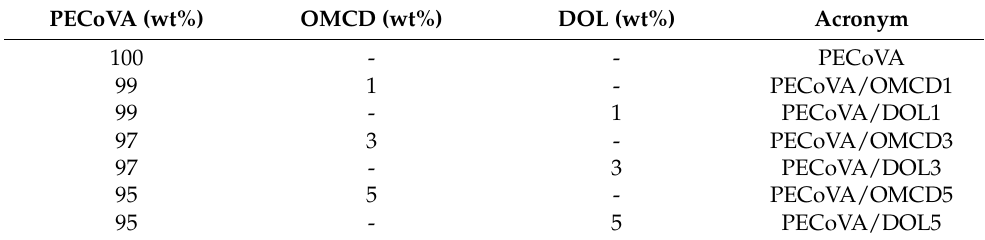
Table 1. Formulation and acronyms of PECoVA/dolomite composites. PECoVA (wt%) OMCD (wt%) DOL